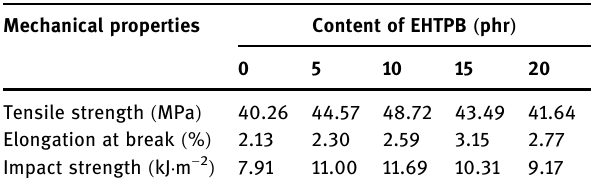
Table 2: Mechanical properties of EP/h - BN ( 40 phr )